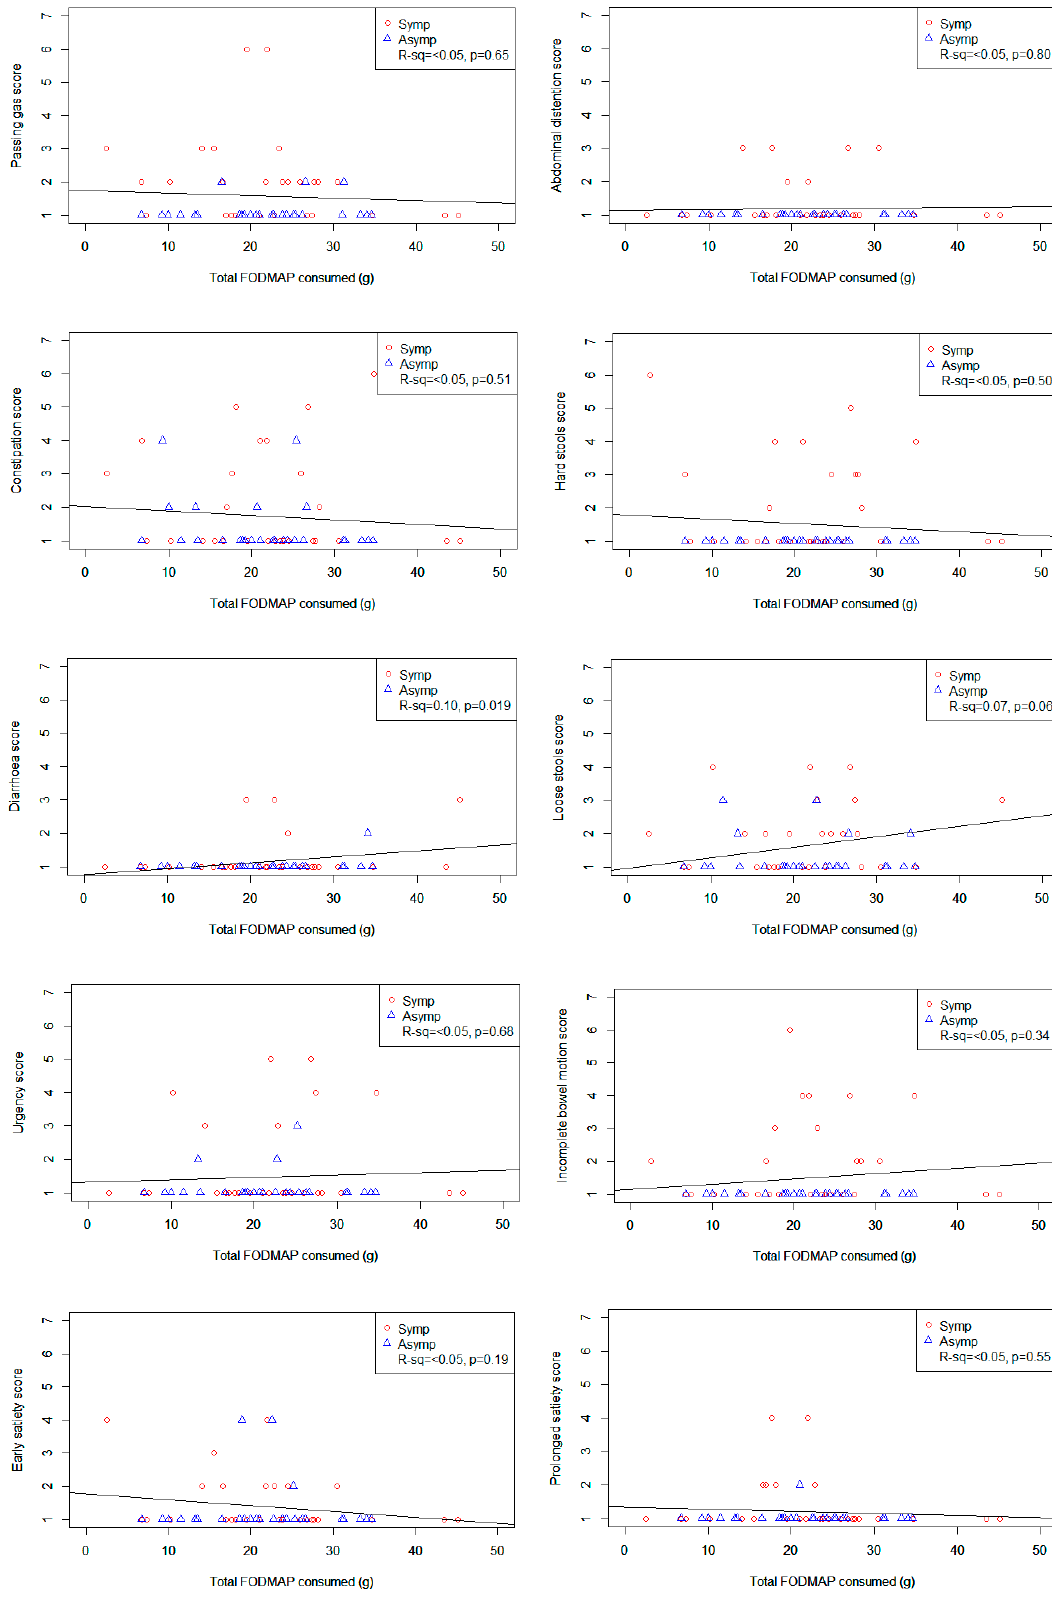
Figure 1. Scatter plots with linear regressions of total FODMAP intake including lactose and various IBS symptom scores. Presented R -squared and p -values indicate the significance of the association between total FODMAP intake and IBS symptom score.